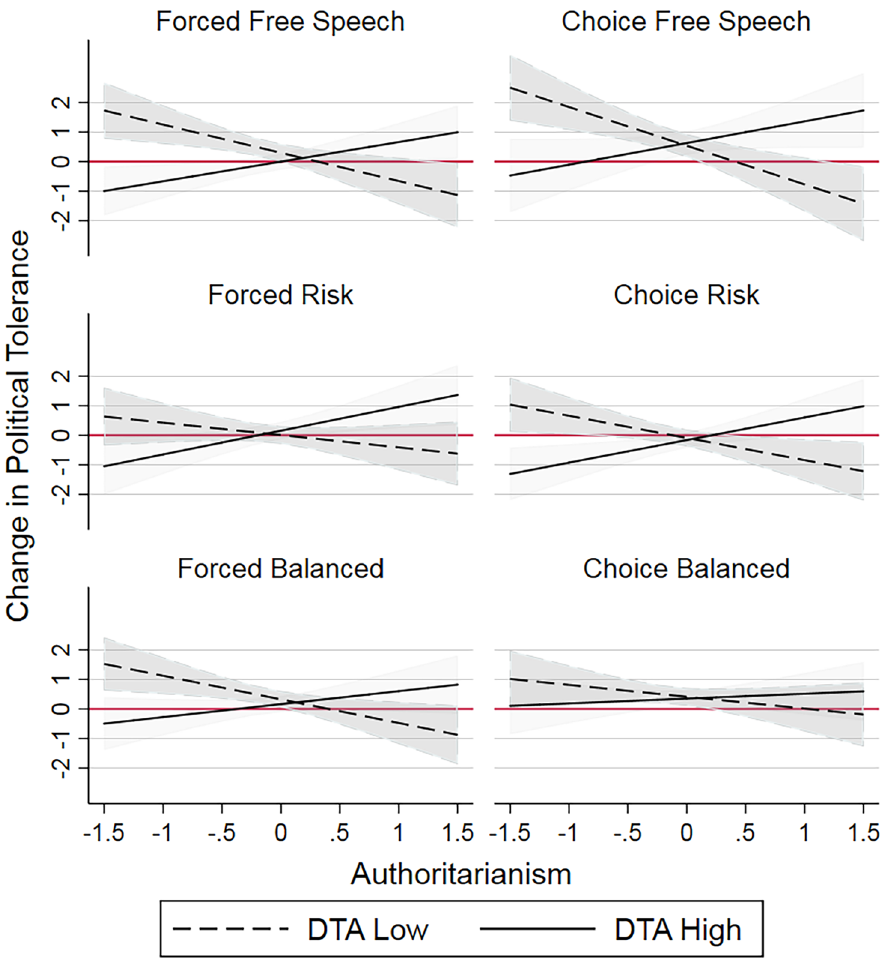
Figure 3. Conditional marginal effects of political messages on political tolerance: Canada.